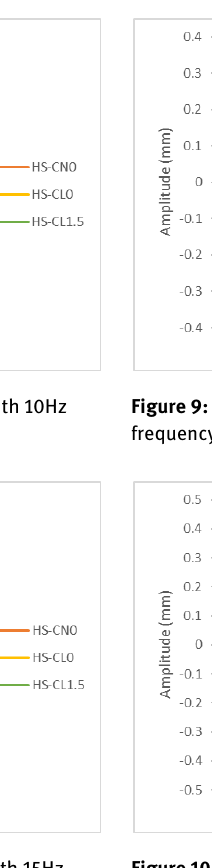
Figure 10: Vibration-time history under harmonic load with 30Hz